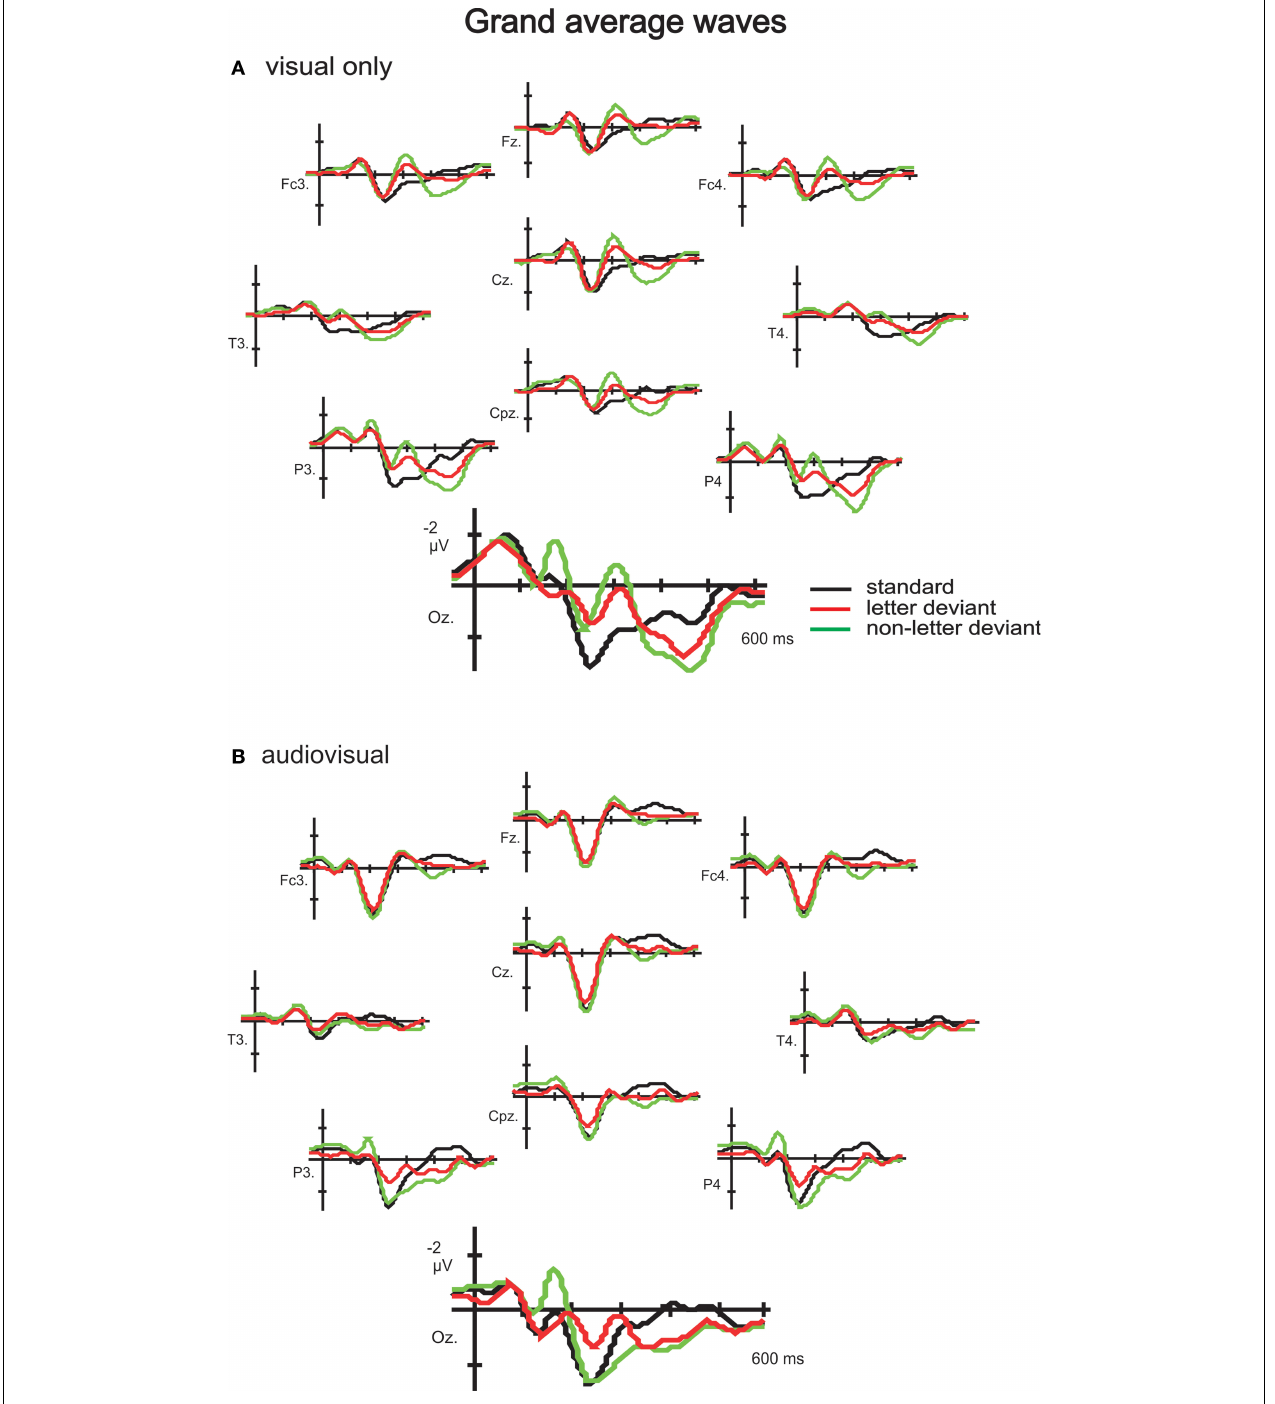
FIGURE 2 | Grand-average waves to standard letters, letter deviants and non-letter deviants observed at 10 electrodes (Fz, Fc3, Fc4, Cz, T3, T4, Cpz, P3, P4 and Oz) in the visual experiment (A) and the audiovisual experiment